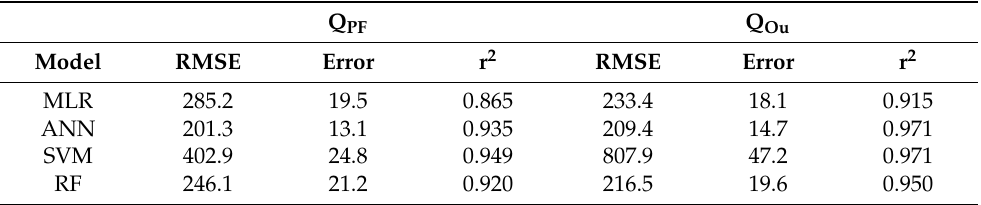
Table 3. Adjustment parameters for each of the best models applied to the stations of Pazo de Fontefiz and Ourense-Estaci ó ns. RMSE is the root mean square error (10 kJ/(m 2 · day)), Error is the average absolute relative error (%) and r 2 is the squared correlation coefficient. Q PF Q Ou Model RMSE Error r 2 RMSE Error r